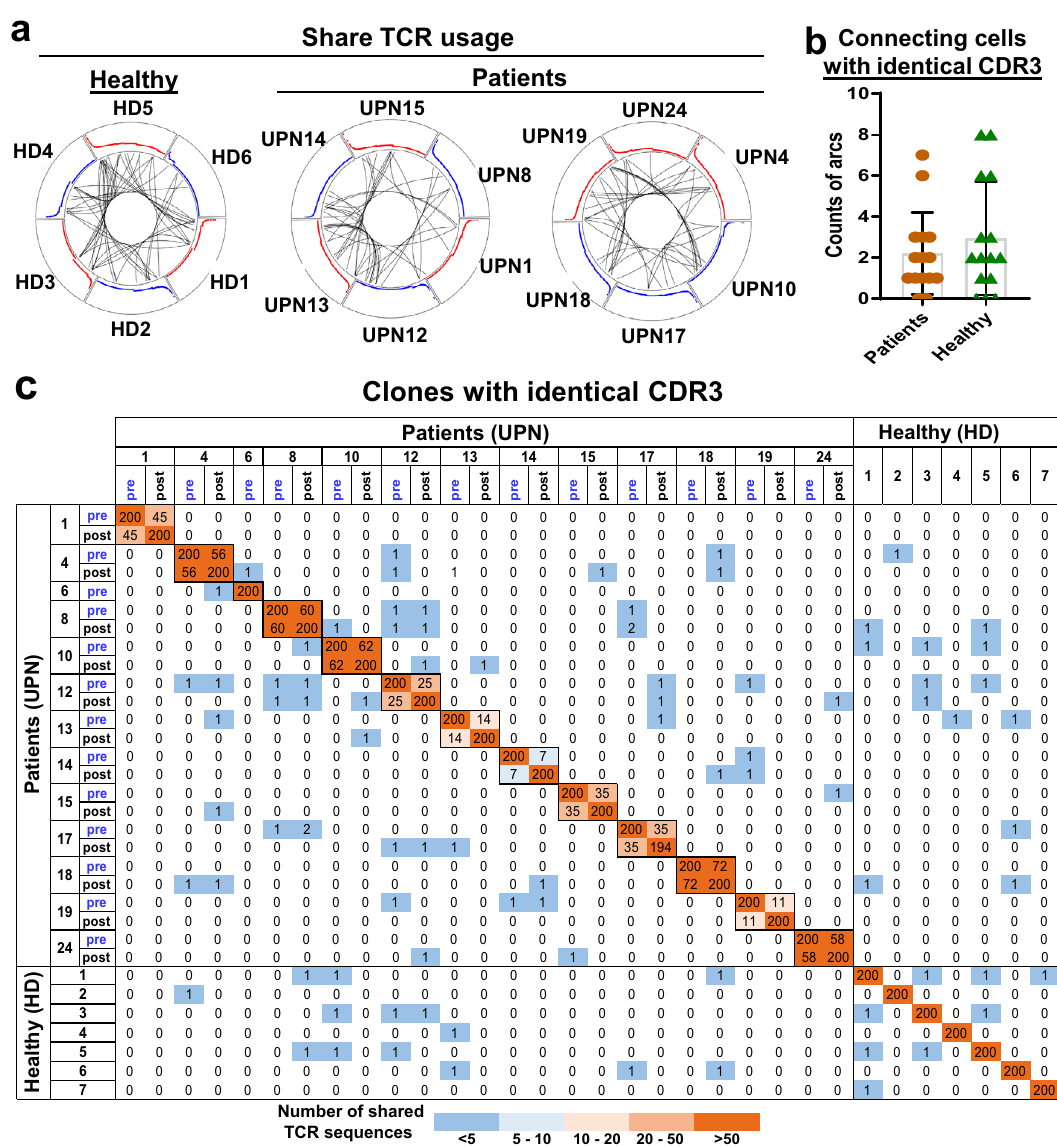
Fig. 3 Lack of common TCRA and TCRB clonotypes in T-LGLL patients. a Circos plots are shown: segments in circles represent individual cells yielding rearranged TCR sequences. Black lines connected clones sharing identical CDR3 sequences among individuals. Sharing of identical CDR3 sequences among six healthy donors (HD1 – HD6) is shown on the left; sharing of identical CDR3 sequences among patients (UPNs 1, 8, 12, 13, 14, and 15) and patients (UPNs 4, 10, 17, 18, 19 and 24) on the right. Red and blue curves are proportional to clone sizes. b Counts of arcs connecting cells with identical CDR3 sequences among patients ( n = 13) and healthy donors ( n = 7) were compared pair-wisely, and there was no signi fi cant difference. Data are presented as mean values ± SEM; two-sided unpaired Mann – Whitney test. c Heatmap plot showing shared CDR3 sequences among the top 200 TCR clones of patients and healthy donors. On both x - and y -axes, samples of patients and healthy donors are listed, and adjacent grids show paired samples (pre- and post- treatments) of the same patients. Counts of identical TCR clones shared among samples are shown. Color scheme, ranging from dark orange to dark blue, indicates the number of shared TCR CDR3 sequences, from high to terminal differentiation, proin fl ammatory, and cytolytic effector map (Fig. 4e) 8,12 . Together, these results suggested that T cell pathways, contributed in the same direction as did T cell acti- phenotypes were contributed by a combination of antigenic TCR vation on dimension 1, perhaps due to a moderate overlap of stimulation and environmental stimulation. On the same diffu- genes in each pathway but also likely from coordination of genes sion map with color coding of expanded and nonexpanded of related functions (Supplementary Fig. 21a – d). When denoted clones, expanded clones clustered at the left side of dimension 1, by colors with T cell subpopulation signature genes in CD8 + indicating an impact of clonal expansion on the transcriptome in T cells, the differentiation trajectory appeared from naive T cells T-LGLL (Fig. 4f). In patients and healthy donors, there was to central and effector memory T cells (Supplementary Fig. 21e, positive correlation between TCR diversity and T cell activation, f). By correlation analysis, 22% of variation across T cell phe- but not with TCR expression (Fig. 4g). In summary, CTL notypes was attributed to TCR expression, and TCR expression expansion in T-LGLL associated with decreased TCR diversity showed a continuous increase on dimension 2 in the diffusion and increased T cell activation.